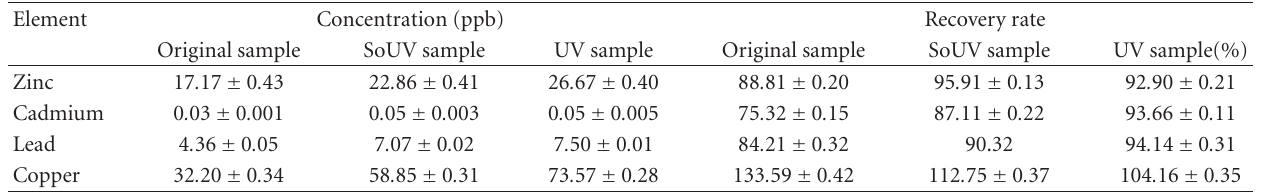
Figure 1: DP stripping voltammograms recorded for (a) the Original Sample , (b) the SoUV Sample , and (c) the UV Sample, with additions of 10, 20, 30ppb for Zn and Cu, 3, 6, and 9ppb for Pb, and 1, 2, and 3ppb for Cd. Table 2: Concentration and recovery rates measured for Zn, Cd, Pb, and Cu in Original Sample , SoUV Sample and UV Sample of Warnow